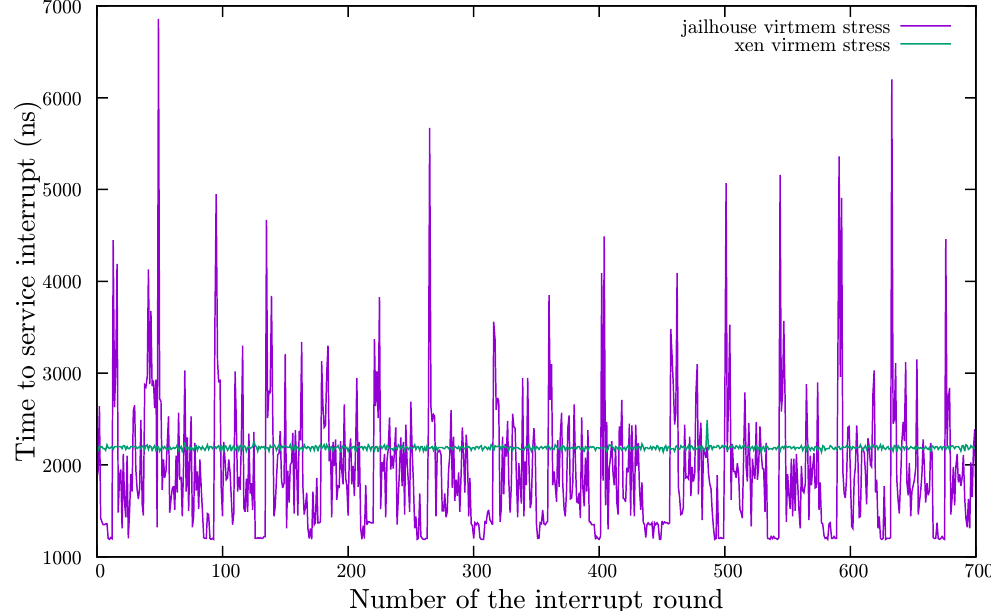
Figure 5. Results for Xen and Jailhouse when the memory module is stressed. The tool also sources a summary of statistical data—for example, see Table 2. In the optimal case, a latency of approximately 1 µs for Jailhouse and 2 µs for Xen were